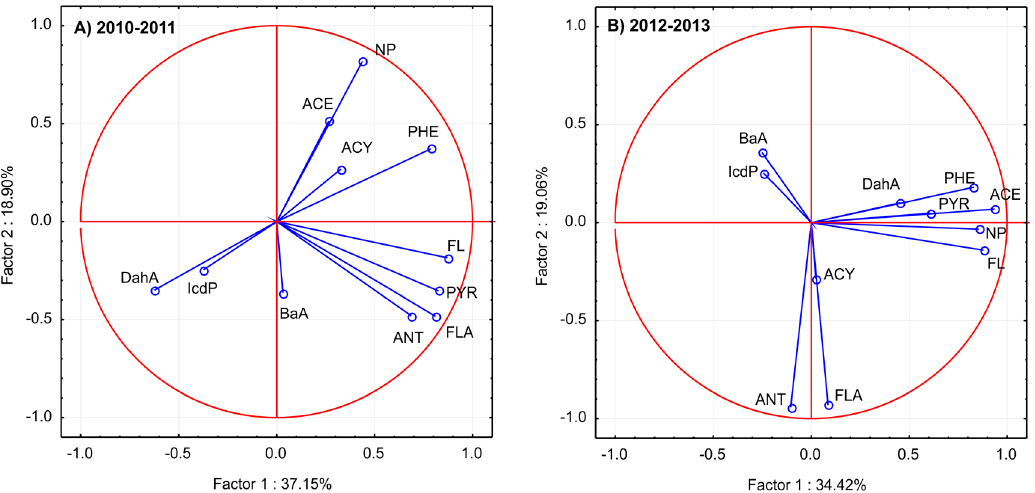
Figure 8. PCA of PAHs in the main stream in Fuglebekken catchment during period of: ( A ) volcanic eruptions 2010–2011; ( B ) without volcanic eruptions 2012–2013. PCA was calculated from the correlation matrix of the standardized concentrations of PAHs. Similar direction of line shows strong inter ‐ correlation between concentrations of PAHs, whereas opposite shows strong negative correlation between concentrations of PAHs. Perpendicular directions of lines shows no inter ‐ correlation.